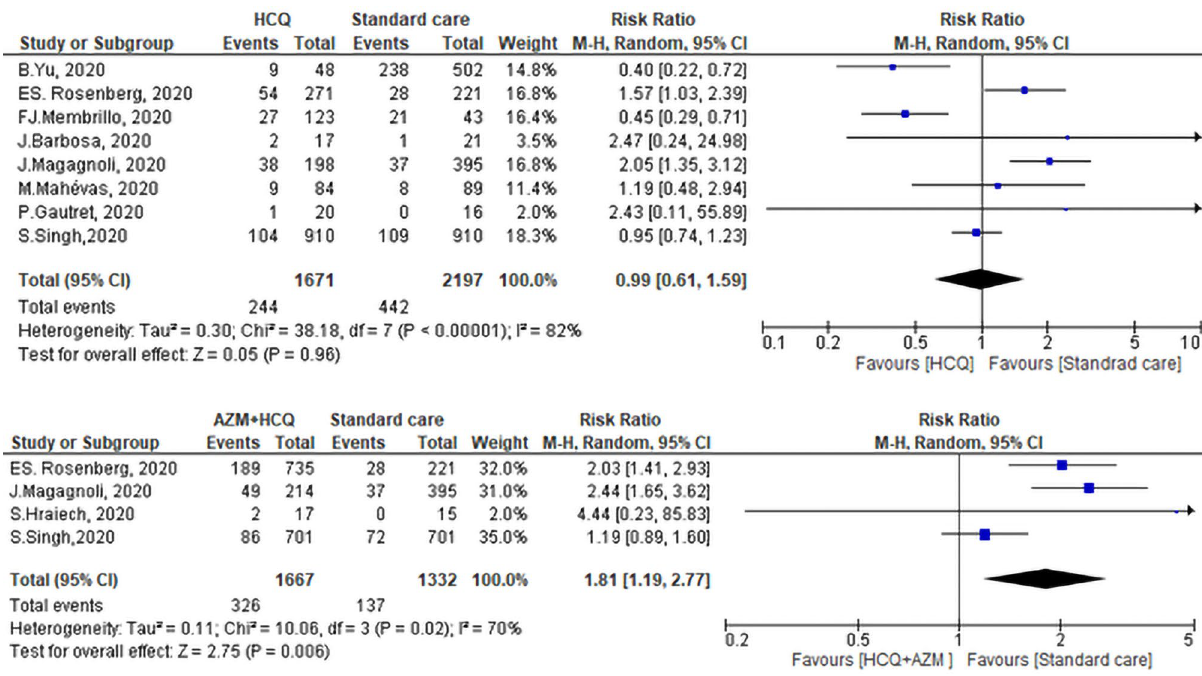
Figure 3. Pooled mortality in the Hydroxychloroquine ± Azithromycin groups versus standard care group.